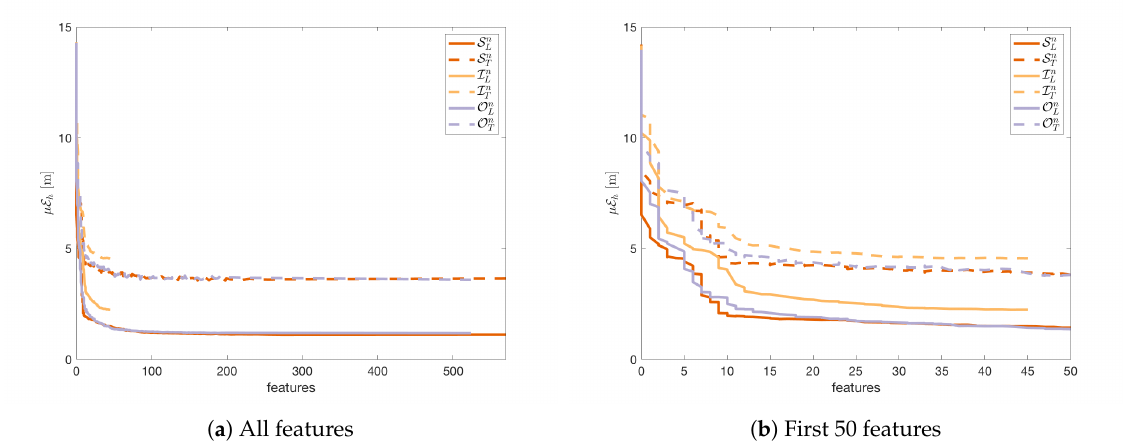
Figure 7. The dependence between the number of features and the obtained horizontal mean error µ E h